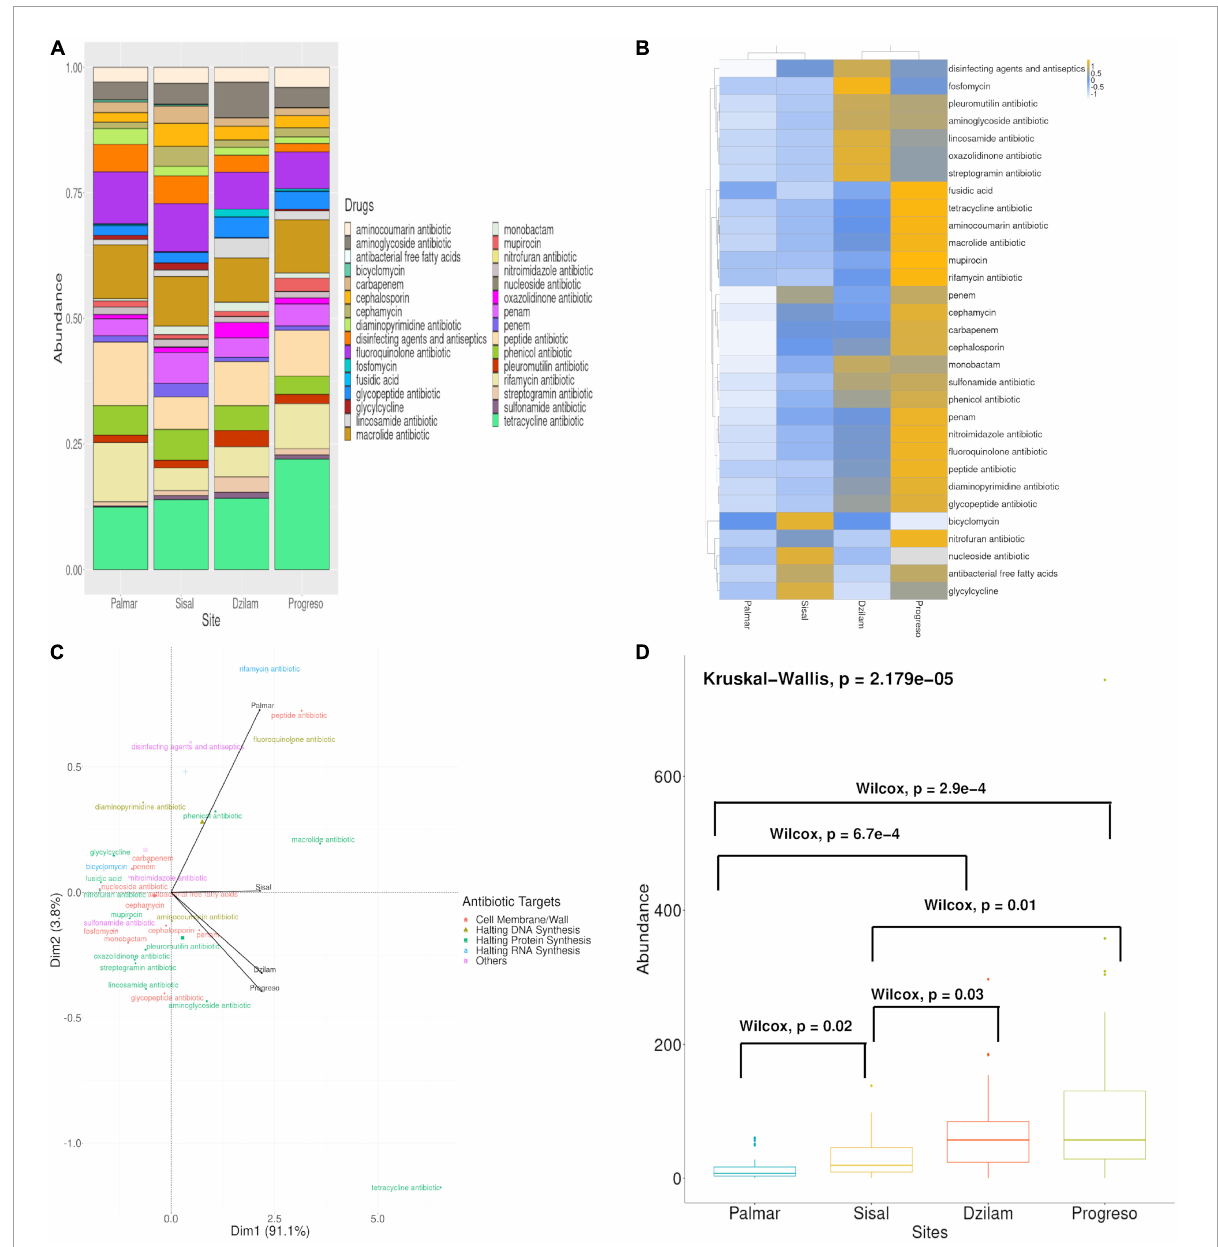
FIGURE2 Antibiotic resistance genes (ARGs) found on the Yucatan coast. (A) Relative abundance of ARGs classes found in the Yucatan coast. (B) Heatmap representing the number of ARGs classes found in each site. (C) Principal component analysis (PCA) analysis represents ARGs classes compositional differences between the sites. (D) Boxplot, Kruskall–Wallis, and Wilcox test of ARGs abundance in the different